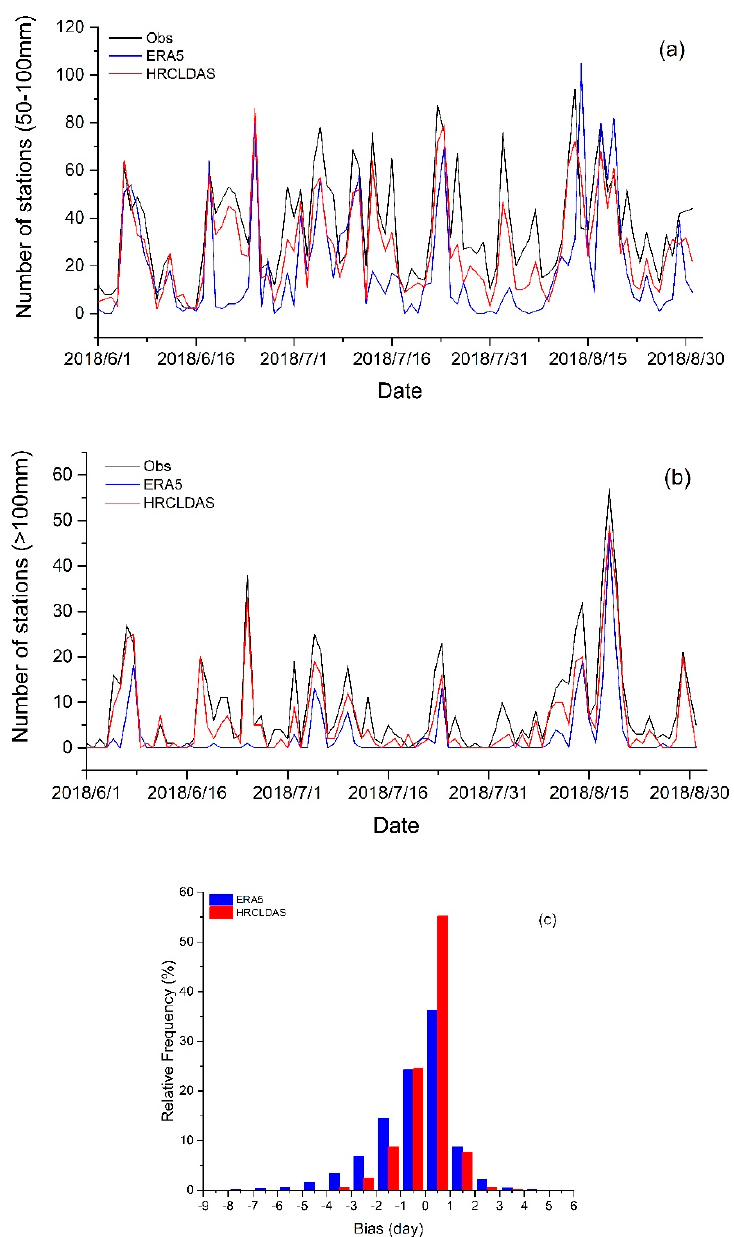
Figure 9. ( a ) Number of rainstorm (50–100 mm) stations in summer 2018 for observations, ERA5 and HRCLDAS; ( b ) number of heavy rainstorm (>100 mm) stations in summer 2018 for observations, ERA5 and HRCLDAS; ( c ) frequency distribution of bias of rainstorm days in summer 2018 for ERA5 and